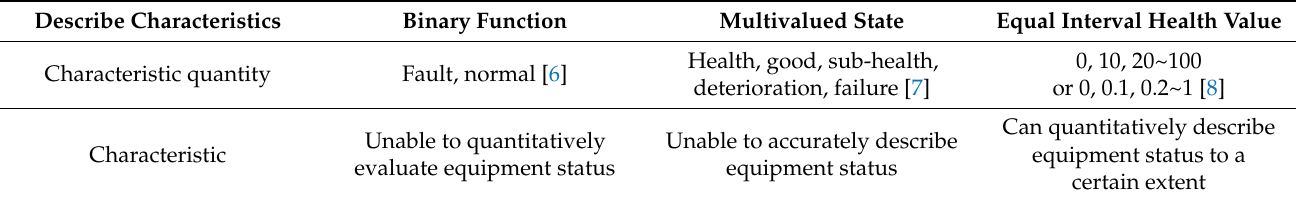
Table 1. Development of health state estimation